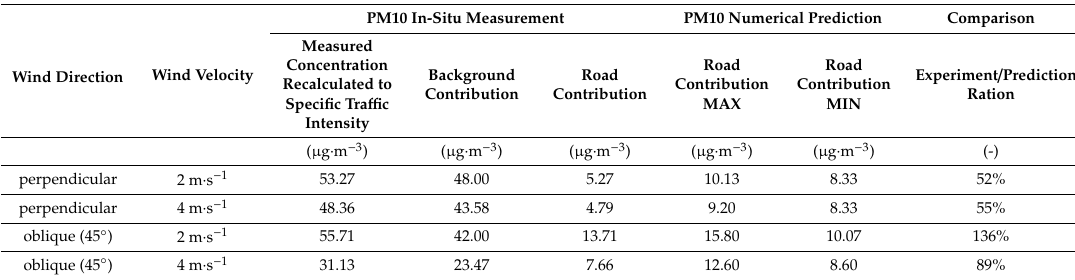
Table 3. Comparison of the computed and the measured values of the road’s contribution to the concentration of PM10 in the ambient